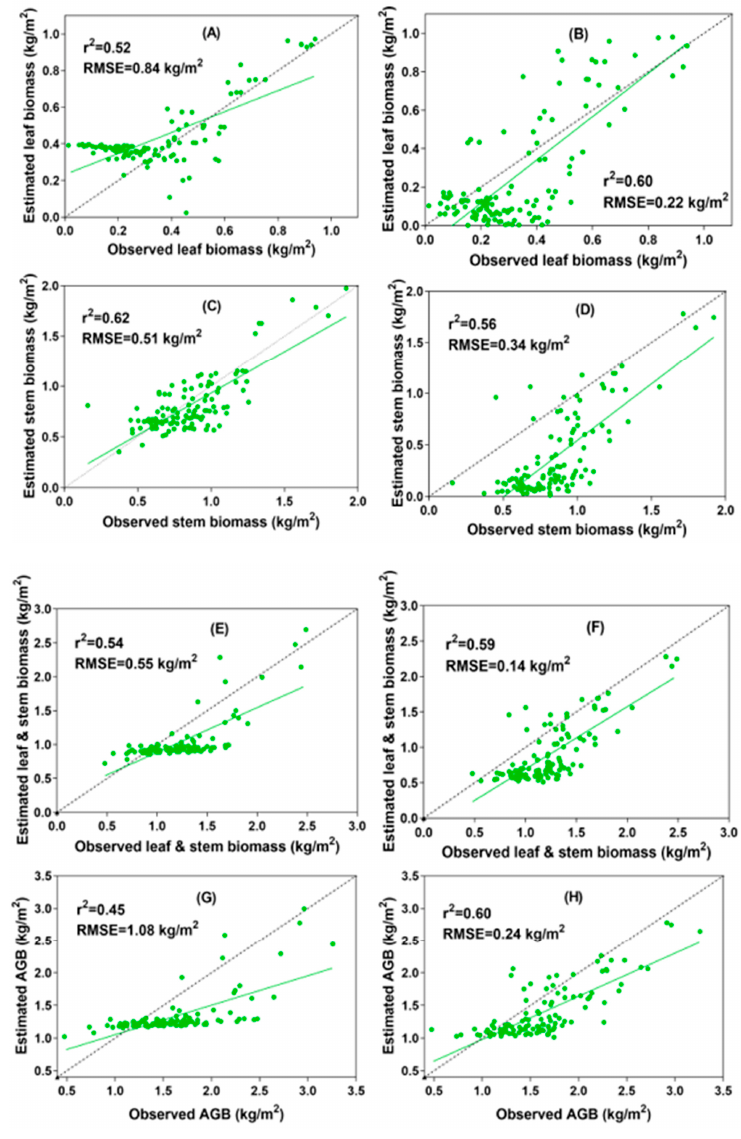
Figure 3. Comparisons between measured and estimated biomass components using single-target Gaussian process regression (SGPR) for ( A ) leaf biomass using RDVI1, ( B ) leaf biomass using SND VH , VV ( C ) stem biomass using RDVI1, ( D ) stem biomass using SND VH , ( E ) stem and leaf biomass using VV RDVI1, ( F ) stem and leaf biomass using SND VH , ( G ) AGB using RDVI1, and ( H ) AGB using SND VH . VV VV The green line represents a linear regression between the observed and estimated values and the dashed line represents the 1:1